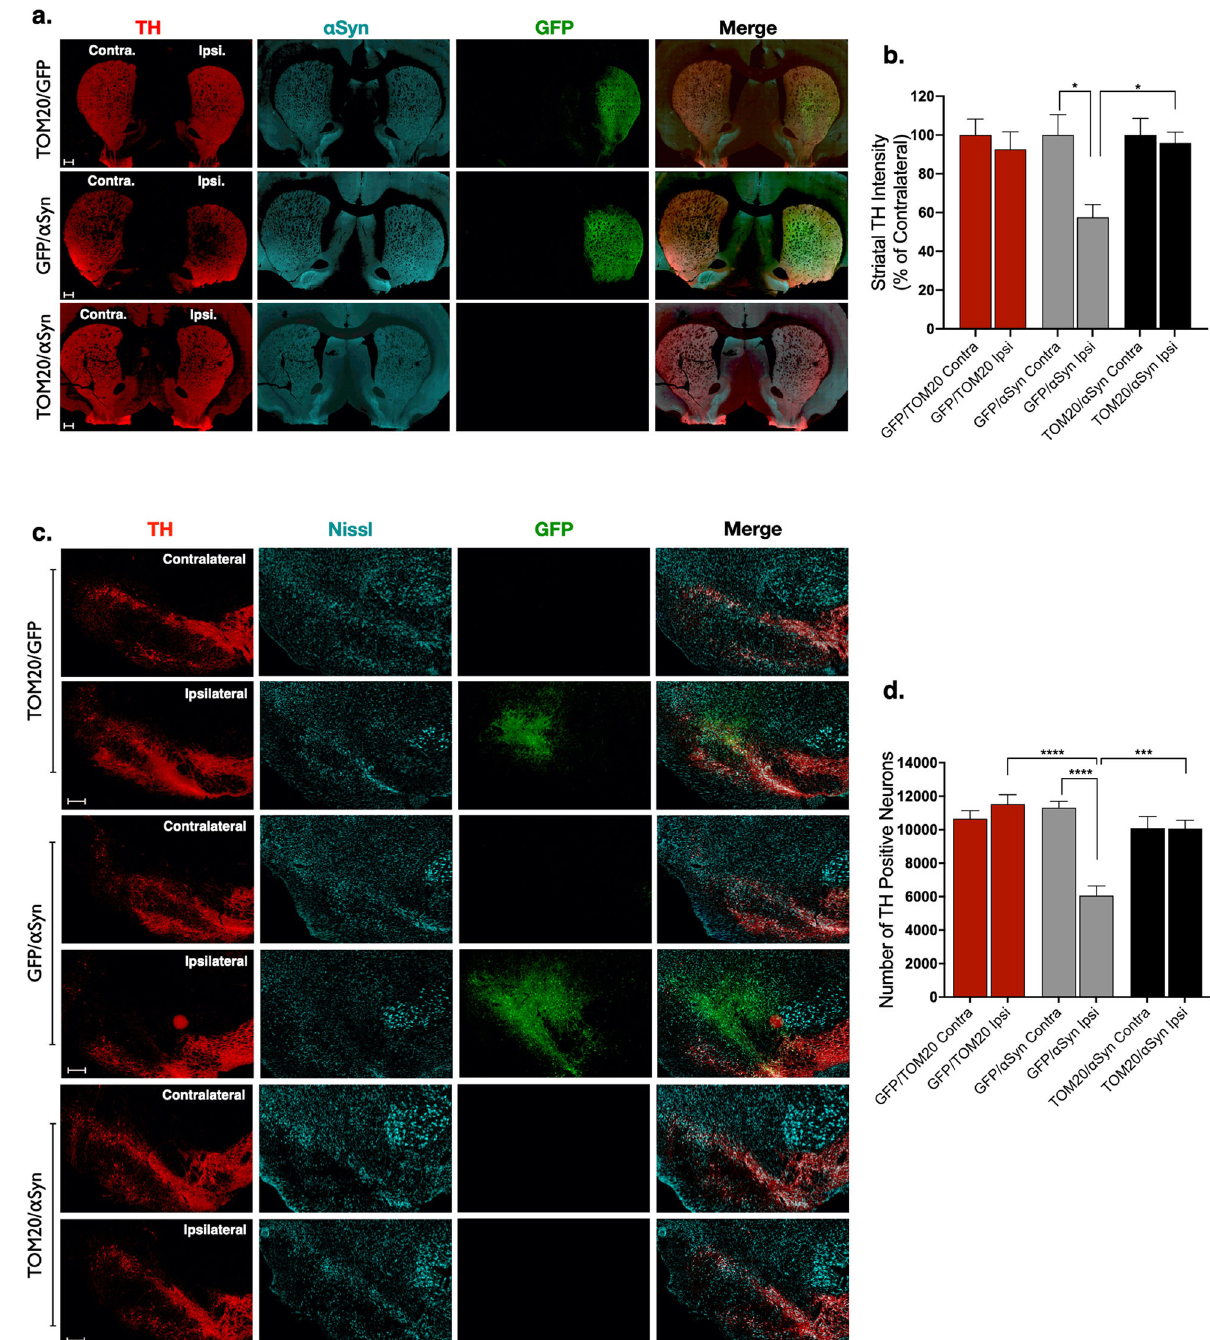
Fig. 3 Overexpression of TOM20 was neuroprotective against AAV2- α Syn-mediated dopaminergic neurodegeneration. Dopaminergic terminals within the striatum (tyrosine hydroxylase; TH; red) were signi fi cantly reduced compared to the contralateral side in animals expressing AAV2- α Syn/GFP, but not in animals expressing AAV2-TOM20/ α Syn; TH (red), α Syn (cyan), GFP (green); (F(5, 95 = 3.0), p = 0.0146, ANOVA; a , b ). Representative images from the ipsilateral and contralateral hemispheres of each treatment group show signi fi cant dopaminergic neuron loss (TH, red) following AAV2- α Syn/GFP treatment, which was reduced by co-expression with TOM20 (AAV2-TOM20/ α Syn); (F(5, 20 = 12.07), p < 0.0001, ANOVA); scale bars 100 μ m ( c , d ). Error bars depict standard error of the mean